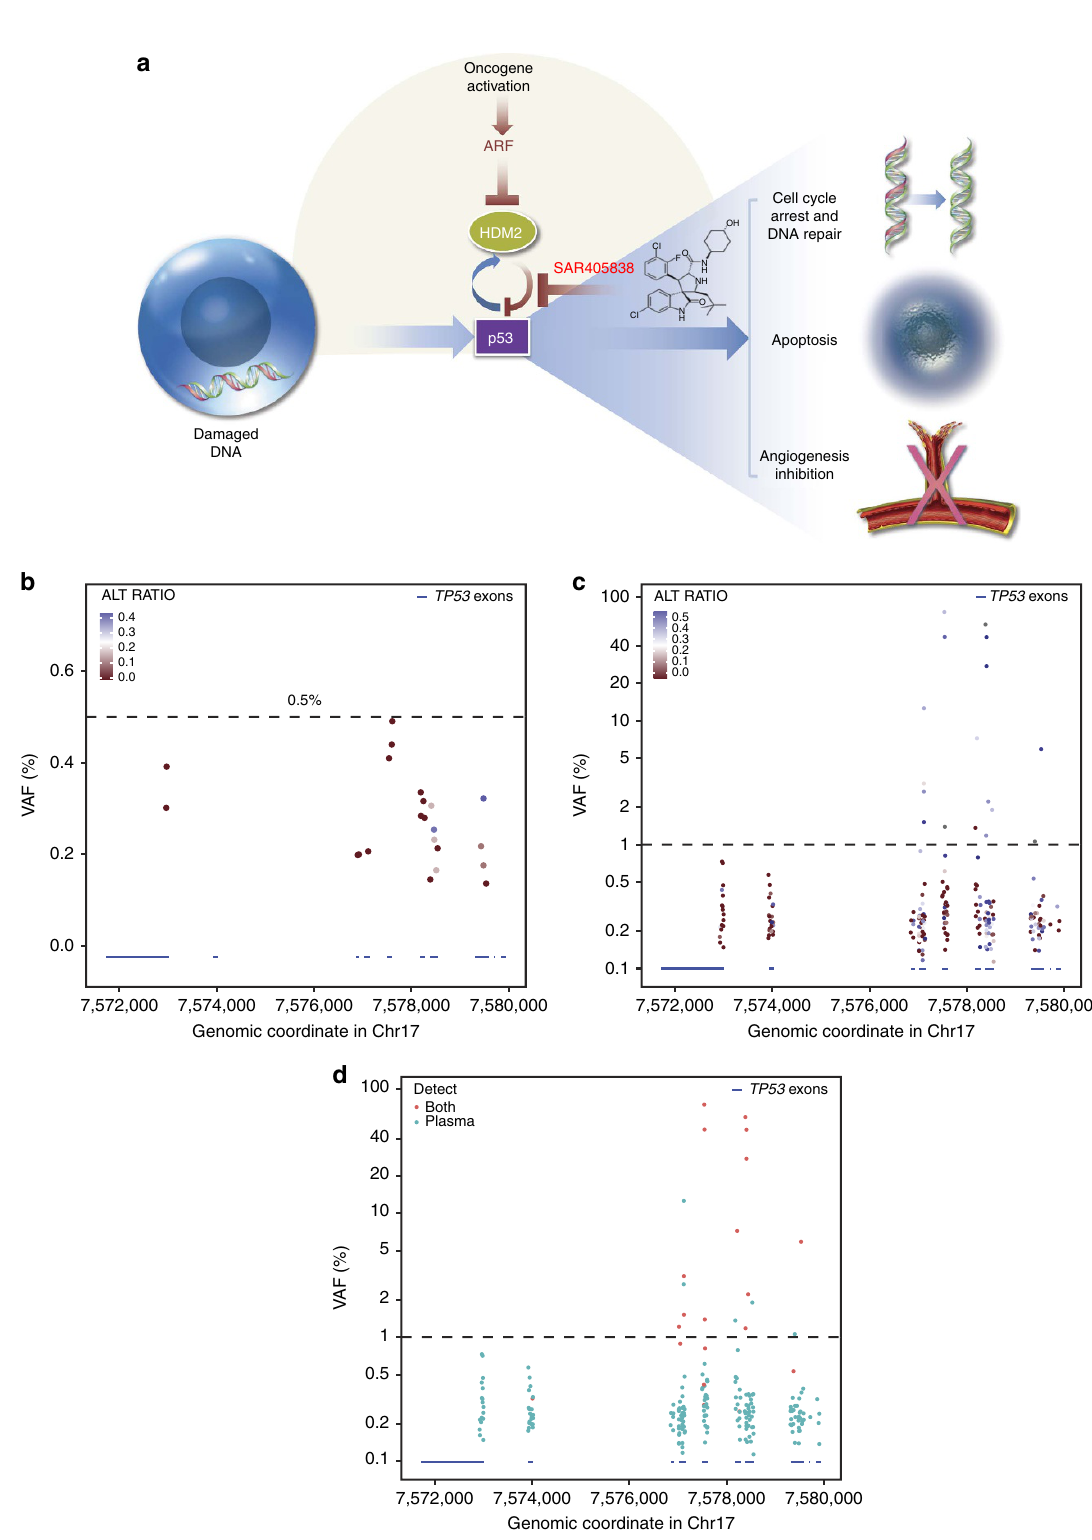
Figure 1 | SAR405838 mode of action and determination of VAF threshold for TP53 mutations. ( a ) SAR405838 inhibits the interaction between HDM2 and p53, resulting in activation of p53 function. ( b ) TP53 mutation VAF in cfDNA samples from normal healthy volunteers ( n ¼ 10). The X axis shows the genomic location of TP53 exons and UTRs (blue bars). Each dot indicates the presence of one TP53 variant. ALT_RATIO, a measure of strand bias, is defined as the proportion of reads in the less-abundant read direction at a base where a variant is detected. A ratio of 0.5 ¼ no strand bias (blue). The dotted line indicates a VAF of 0.5%. ( c ) TP53 mutation VAF in cfDNA samples from 60 matched CRC and NSCLC tumour/plasma pairs. Each dot indicates the presence of one TP53 variant. The dotted line indicates a VAF of 1%. ( d ) TP53 mutation tumour concordance in cfDNA samples from 60 matched CRC and NSCLC tumour/plasma pairs. Each dot indicates the presence of one TP53 variant in cfDNA. Red dots indicate variants that were also present in the matched tumour sample. The dotted line indicates a VAF of 1%. cfDNA, cell-free DNA; CRC, colorectal cancer; NSCLC, non-small cell lung cancer; VAF, variant allele